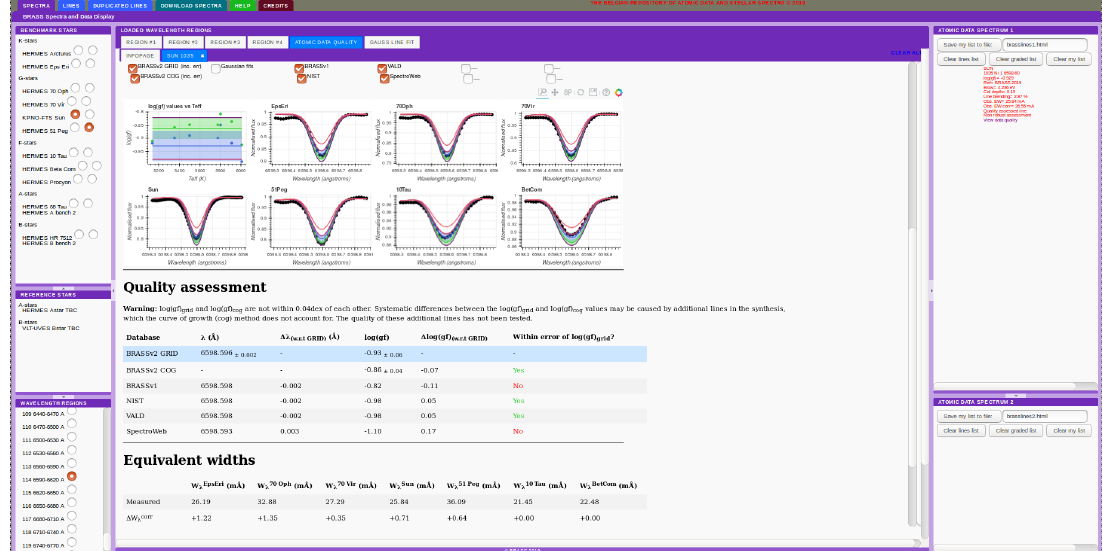
Figure 4. Screencopy of the SBDI page for the atomic data quality assessment results of the Ni I λ 6598 line observed in seven BRASS benchmark spectra. The observed and theoretical line profiles shown in the sub-panels can be displayed with user interaction. The SBDI pages offer an overview of all atomic data quality results for each investigated line together with the observed and theoretical line equivalent width values (see